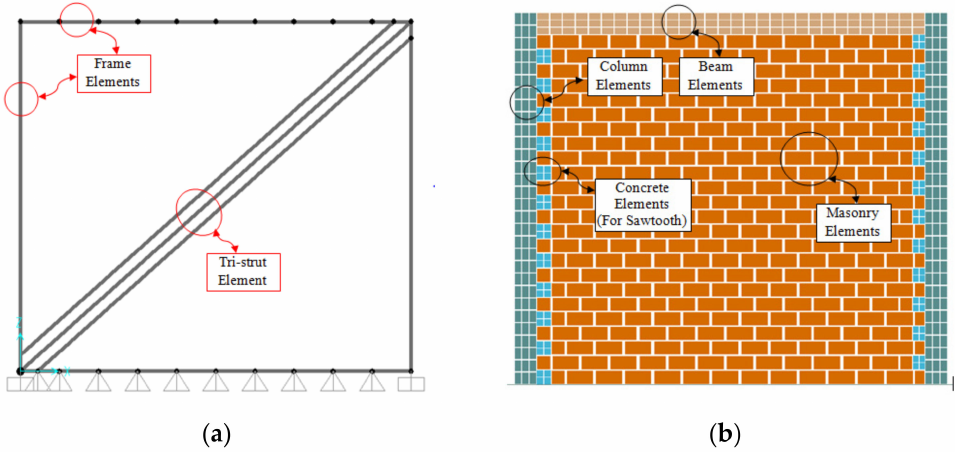
Figure 12. Confined masonry (CM) wall structure: ( a ) Tri-strut Finite Element model; ( b ) Continuum Applied Element